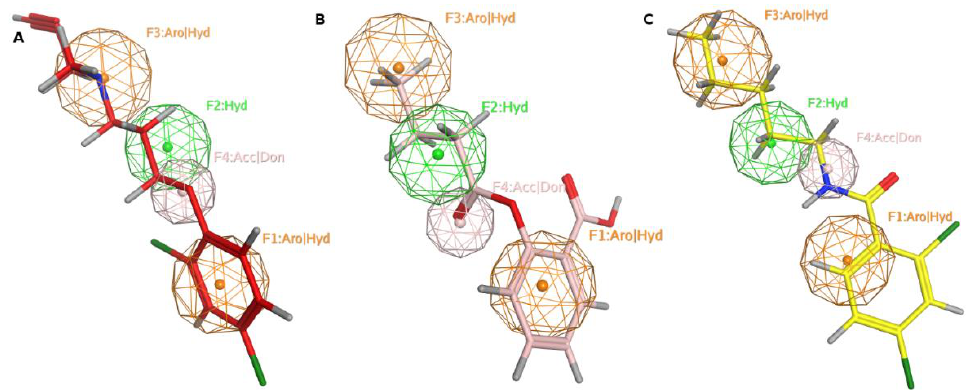
Figure 2. MAO-A pharmacophore model with ( A ) MLG ( S1 ), ( B ) NSC215, and ( C ) NSC6884 Aro stands for aromatic ring, Hyd: hydrophobic, Acc: acceptor, Don: donor. Picture made by MOE [27] .